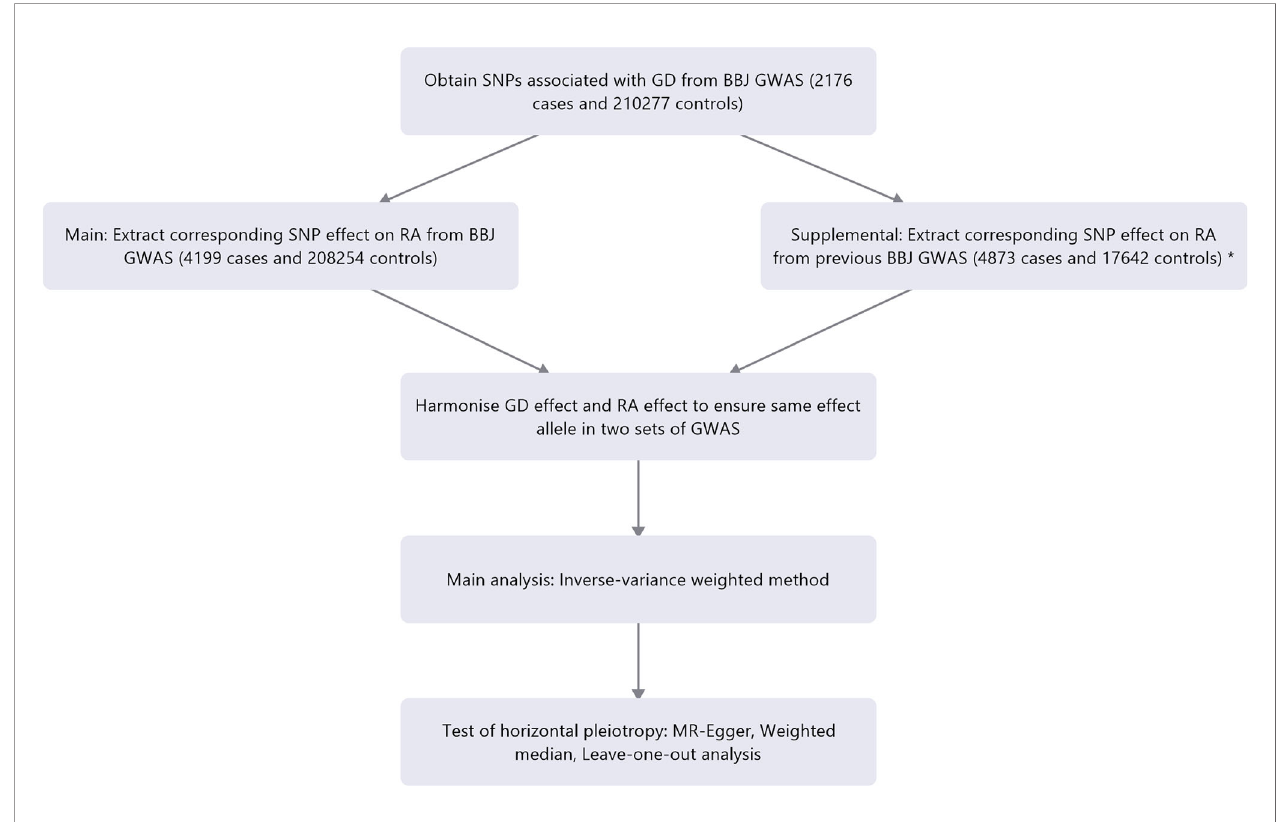
FIGURE 2 | Flowchart of the study process.